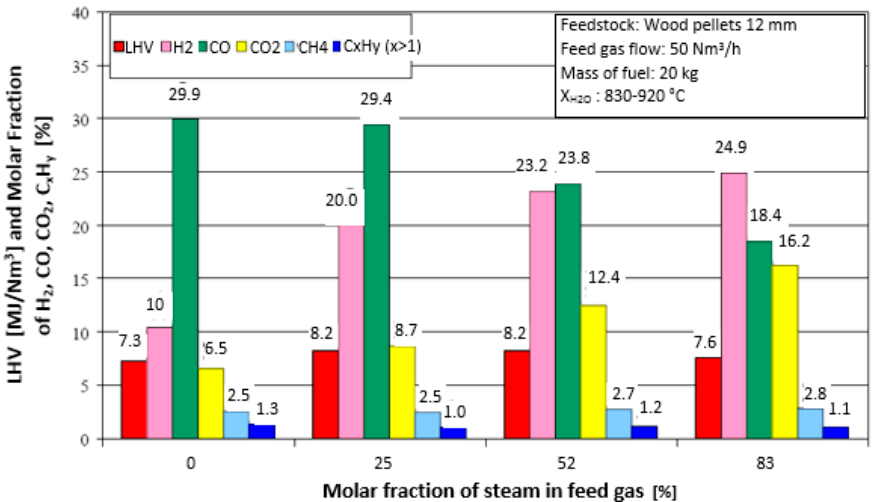
Figure 14. Influence of molar fraction of steam on the average values of composition and lower heating value of the fuel gas—gasification of 20 kg of 12 mm wood pellets (computed results).